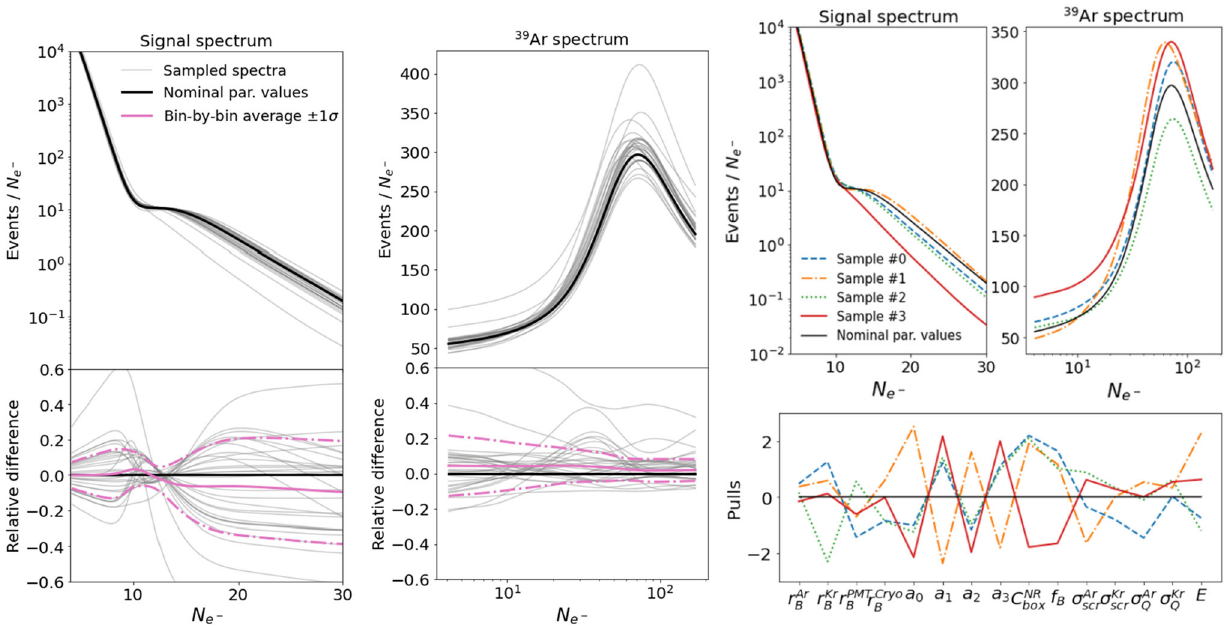
Fig. 6 (Left) Signal (left) 39 Ar background (right) spectra obtained by randomly selecting 30 points from the nuisance parameters pdf , the bottom plots show the relative difference with the spectrum obtained with the nominal parameter values (black solid line) and the average (pink solid curve) ± σ envelopes (pink dashed lines) calculated bin by